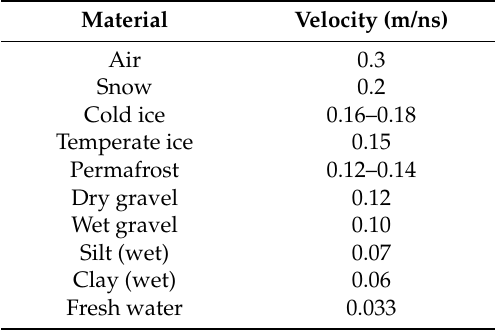
Table 1. Common ground-penetrating radar (GPR) velocities for a range of materials in order of decreasing velocity. Compiled and adapted from [6,12–14].